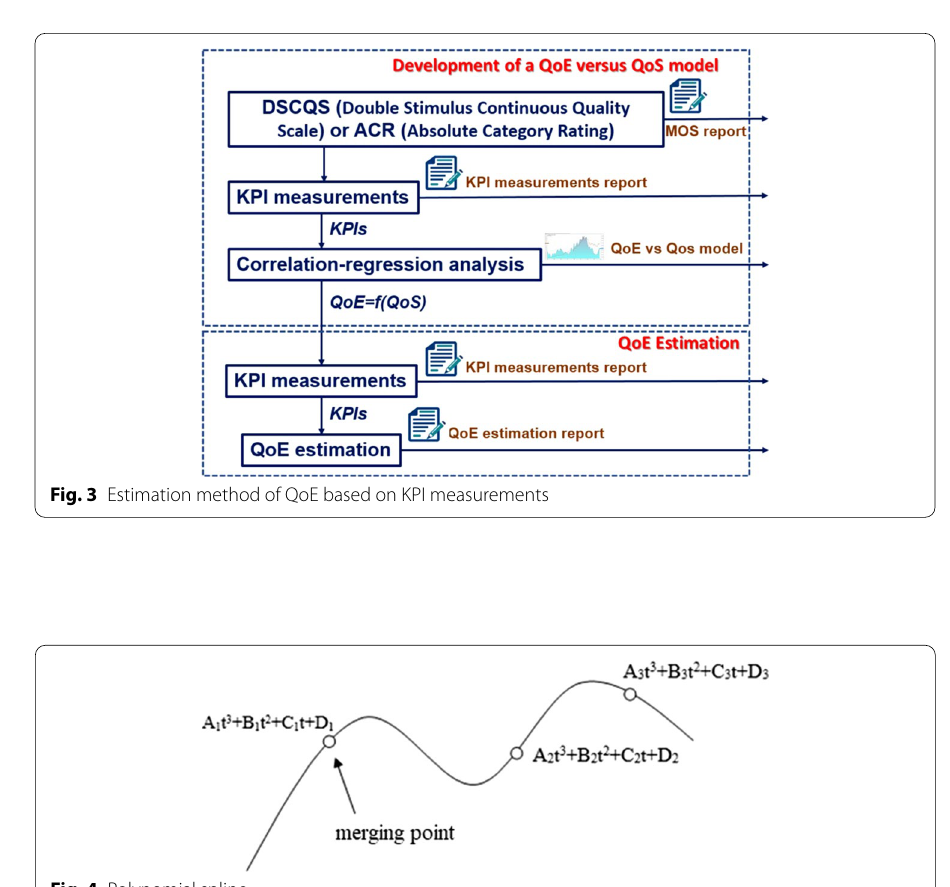
Fig. 4 Polynomial